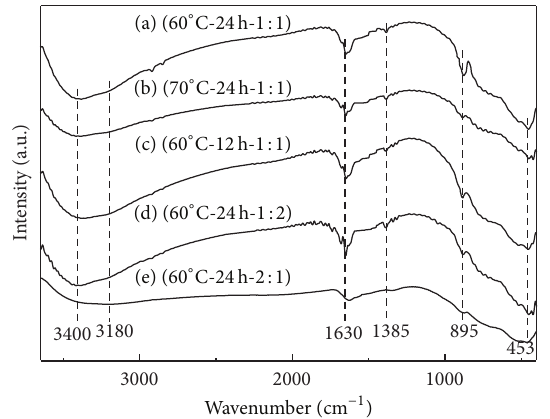
Figure 4: FT-IR spectra of